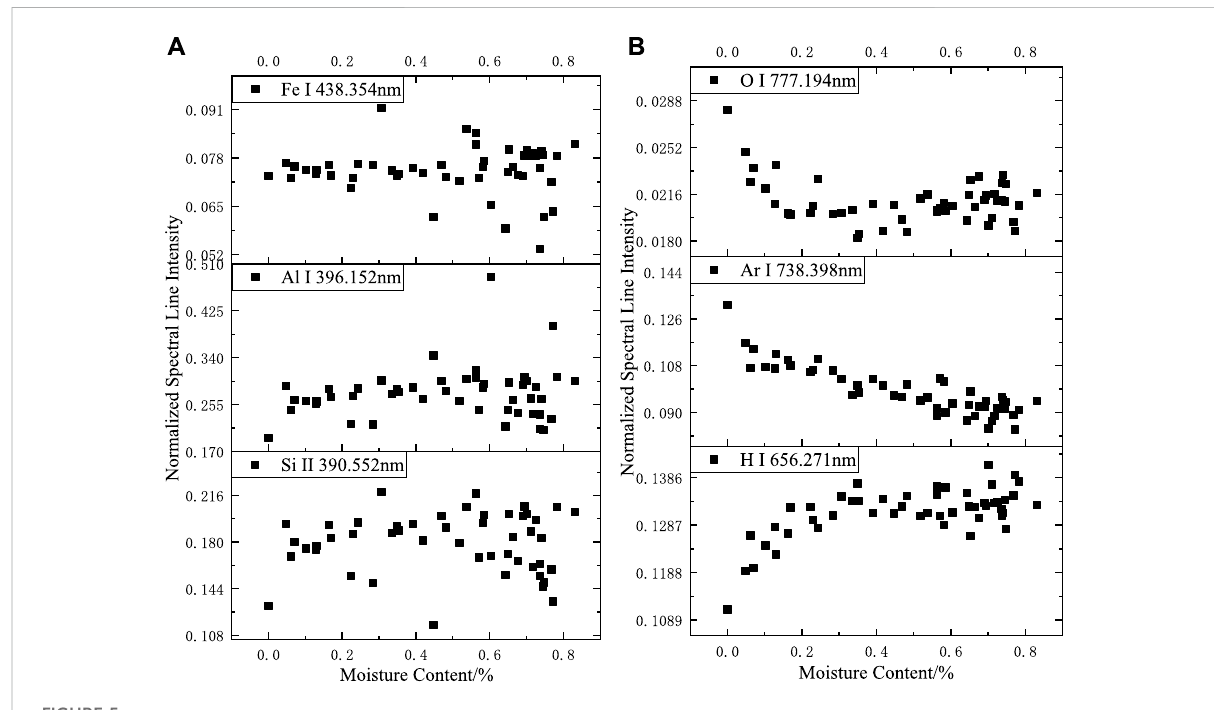
FIGURE 5 Relationship between normalized spectral line intensity and sample moisture content in argon: (A) Fe I 438.354 nm; Al I 396.152 nm. Si II 390.552 nm, (B) O I 777.194 nm; Ar I 738.398 nm. H I 656.271